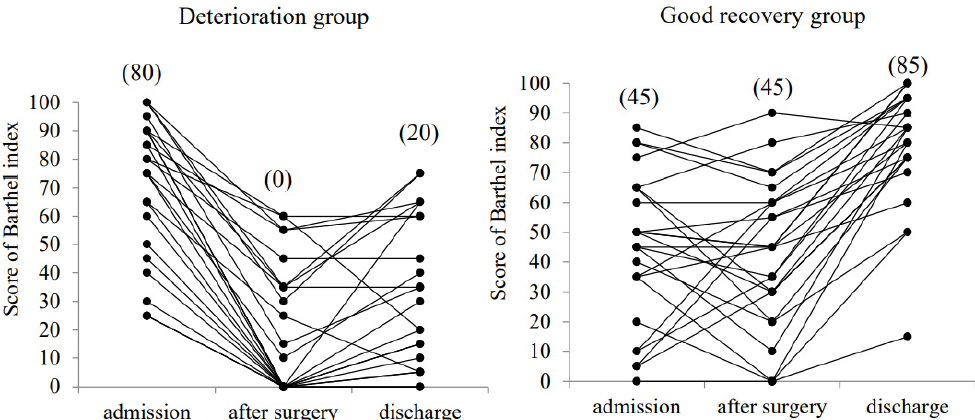
Figure 2. Change in the Barthel index score at admission, at 7 days after surgery (after surgery), and at discharge. The median values are shown in the parenthesis.